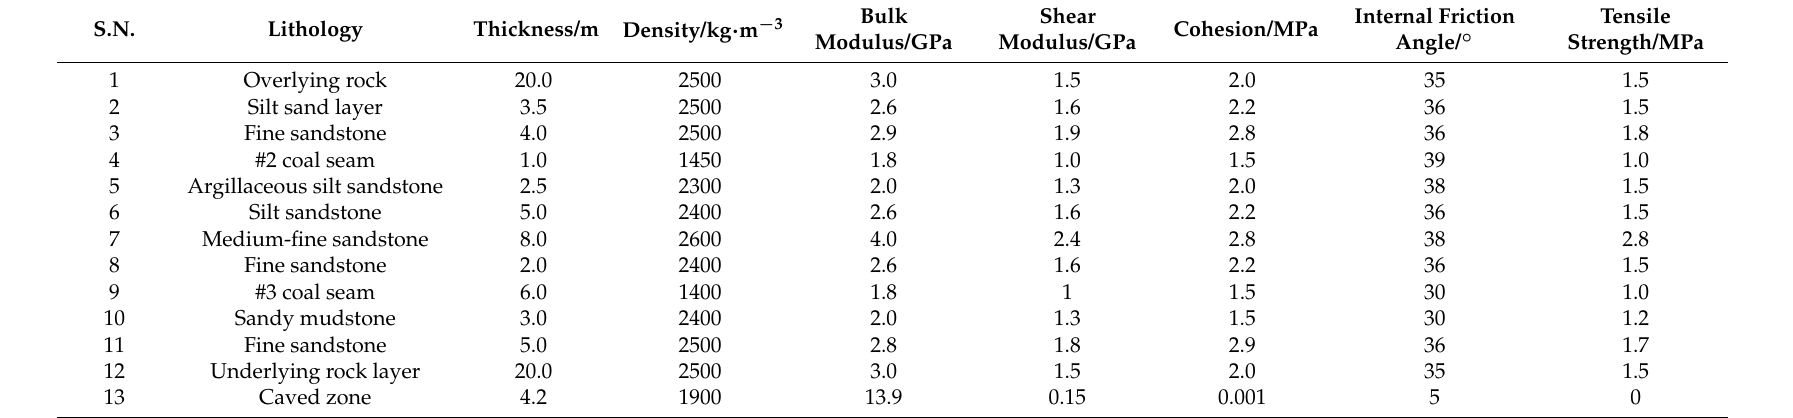
Table 2. Physical and mechanical parameters of rocks and